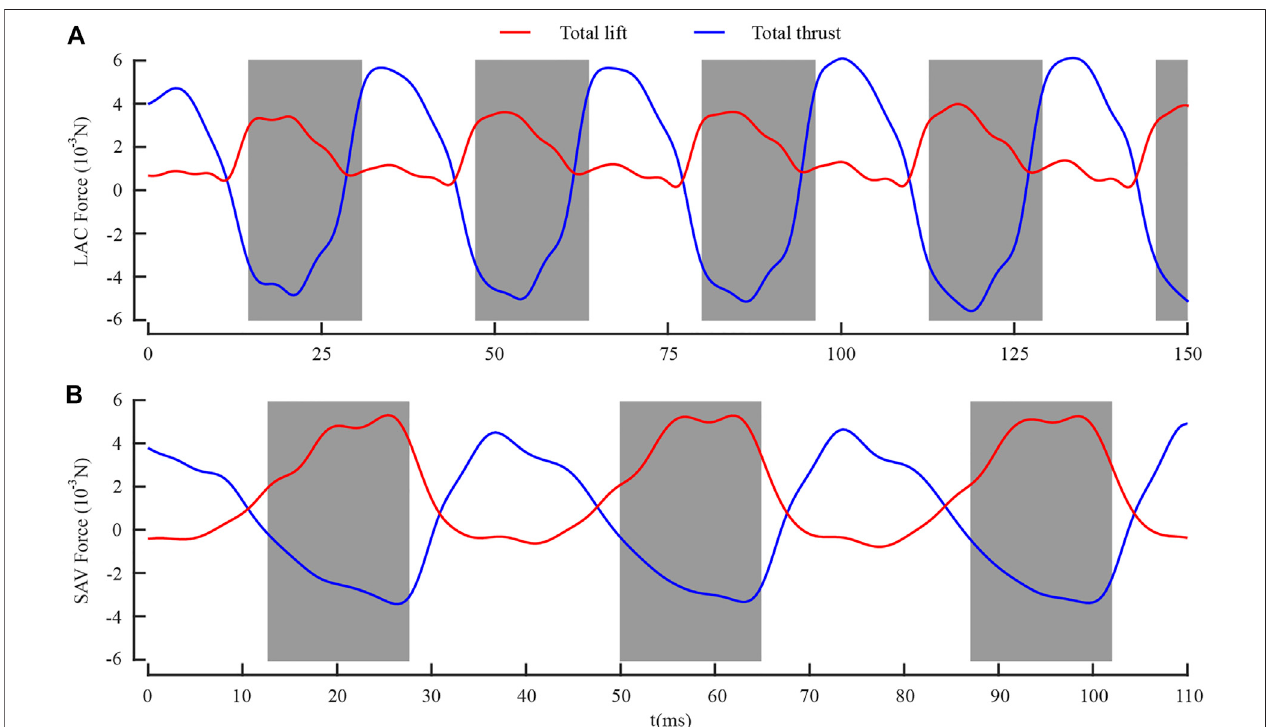
FIGURE 6 | Time courses of (A) lift and thrust during LAC; (B) lift and thrust during